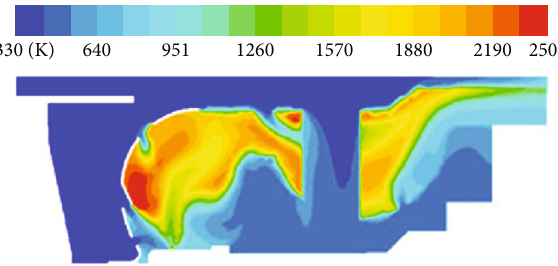
Figure 11: Distribution of temperatures at the speed of 80% design speed.